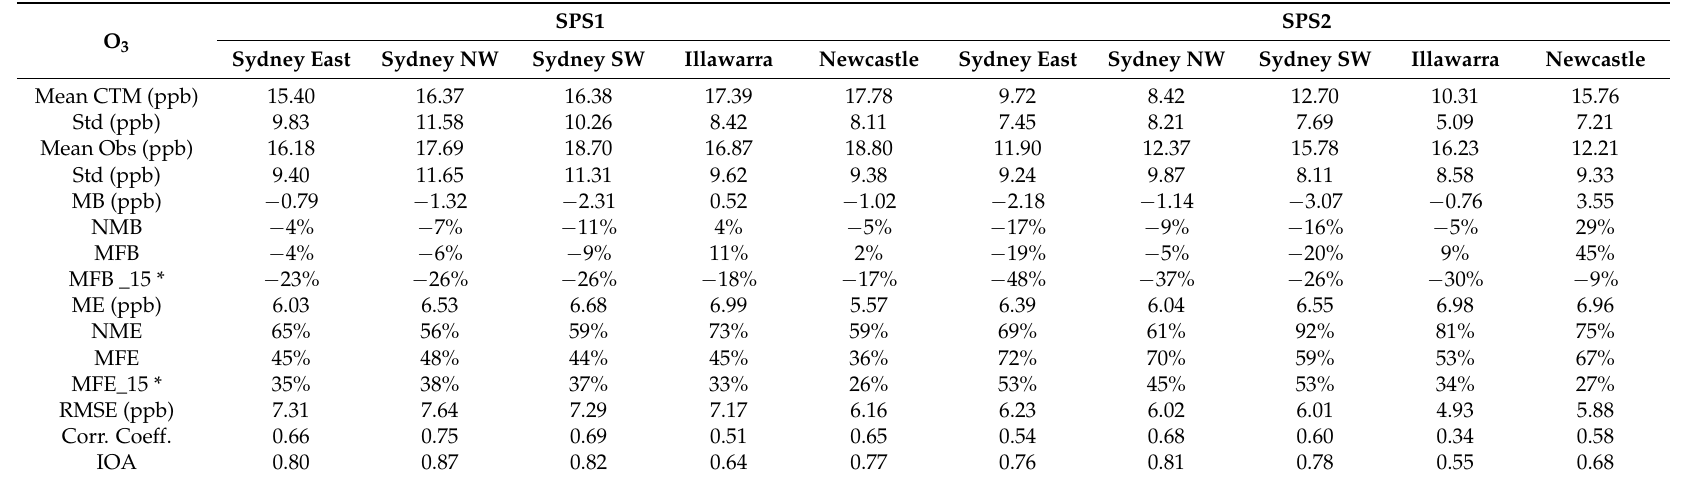
Table 3. Quantitative performance statistics for predicted hourly O 3 concentration against observations in the Sydney East, Sydney NW, Sydney SW, Illawarra and Newcastle regions for the periods of SPS1 and SPS2.